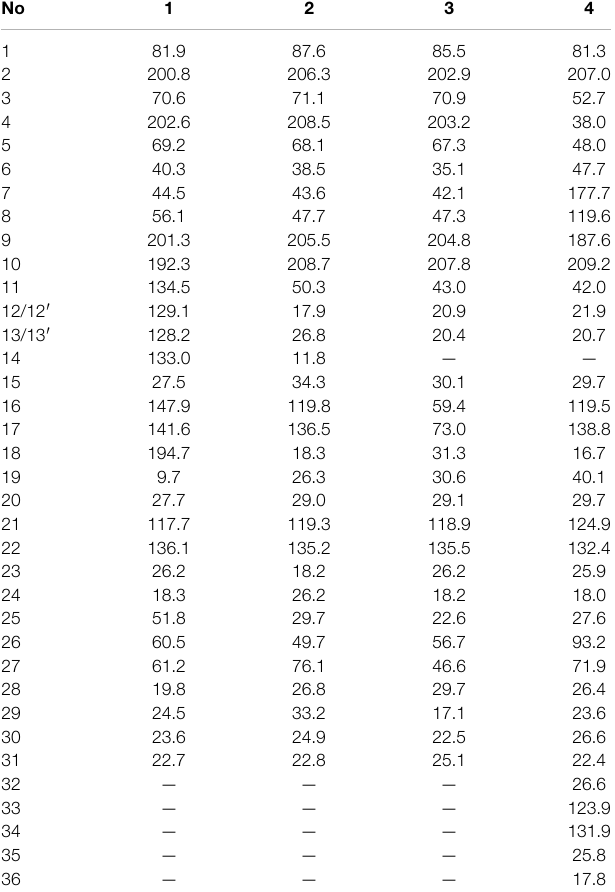
TABLE 2 | 13 C NMR (150 MHz) data of compounds 1-4 in CDCl 3 ( δ in ppm). TABLE 3 | 1 H NMR (600 MHz) data and 13 C NMR (150 MHz) data of compounds 5 and 6 in CDCl 3 ( δ in ppm, J in